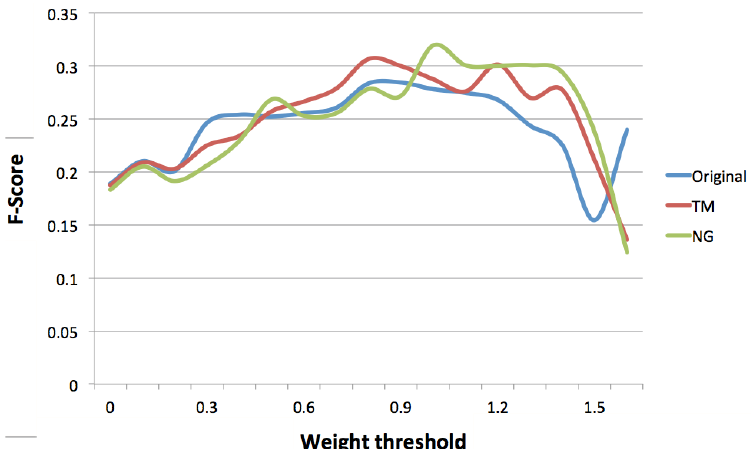
Figure 2. F-score at different concept weight